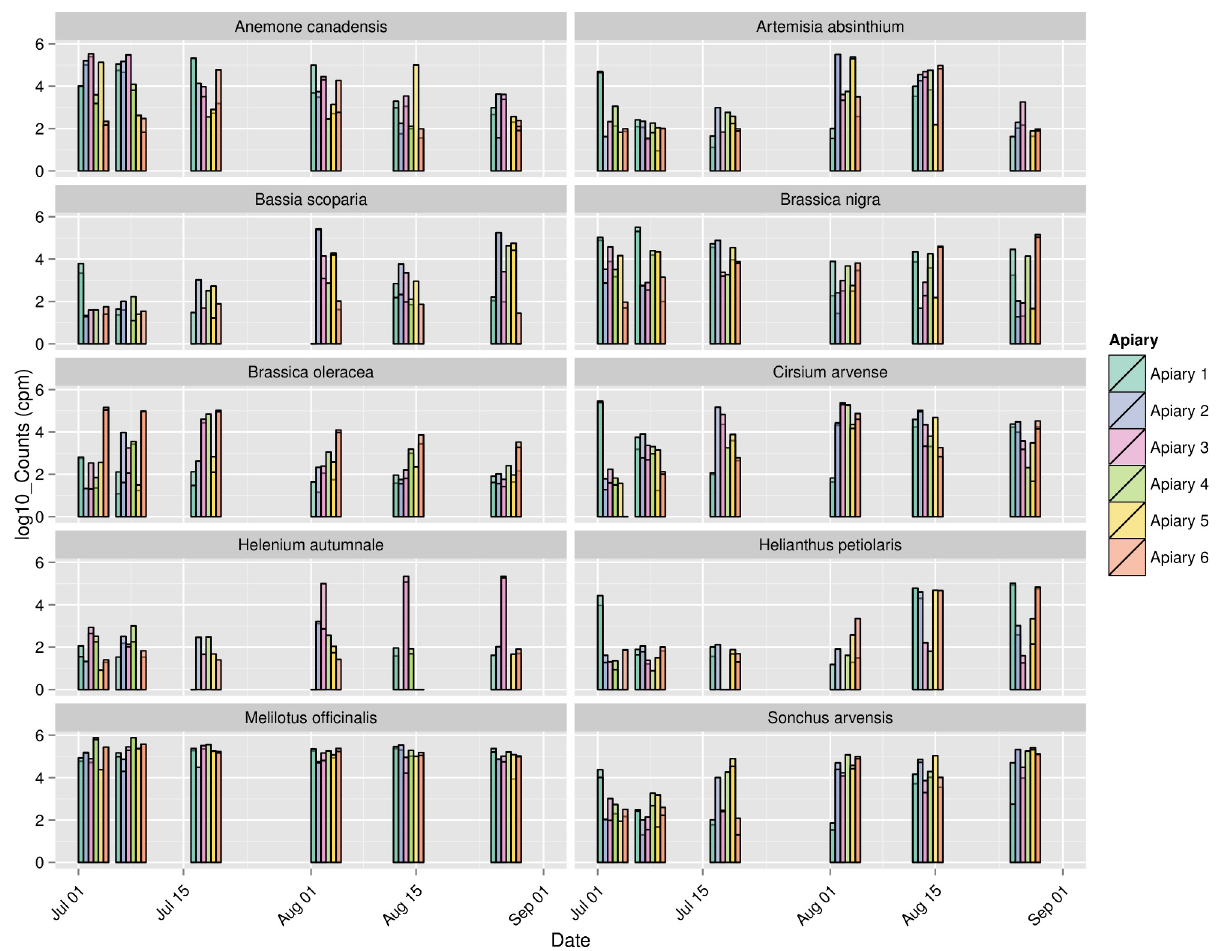
Fig 5. Forage calendar highlighting variation in pollen collection among 6 apiaries in 2009. Combined OTU counts for each of the 10 most common plant species-level assignments, based on the summed counts for all apiaries in 2009, are represented. Vertical axis represents the log 10 transformed counts per million mapped reads (cpm) for each taxon at each sampling point. Vertical bars are transparent to show data for multiple colonies sampled within the same apiary.